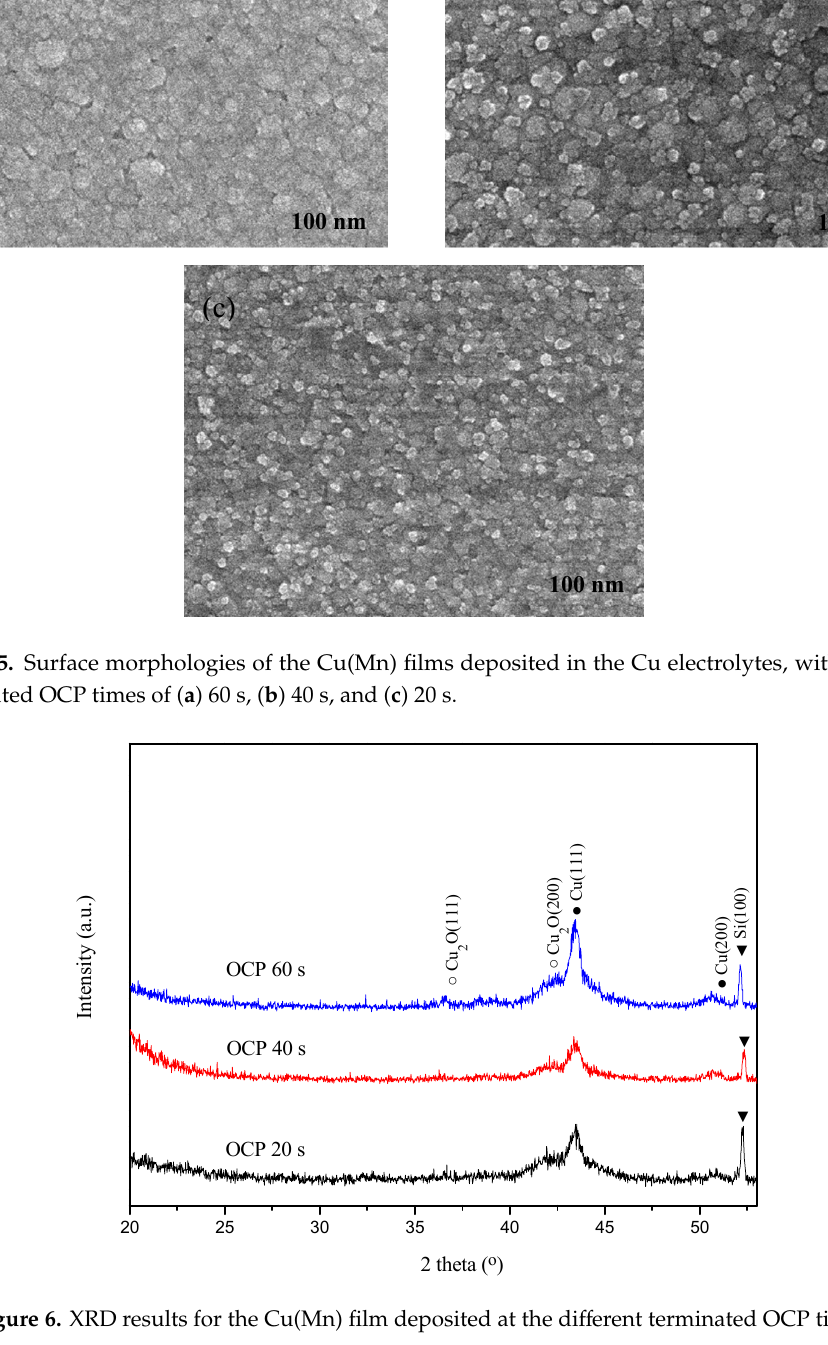
Figure 6. XRD results for the Cu(Mn) film deposited at the different terminated OCP times. Table 2. Composition results of Cu(Mn) films deposited at their respective OCP times.